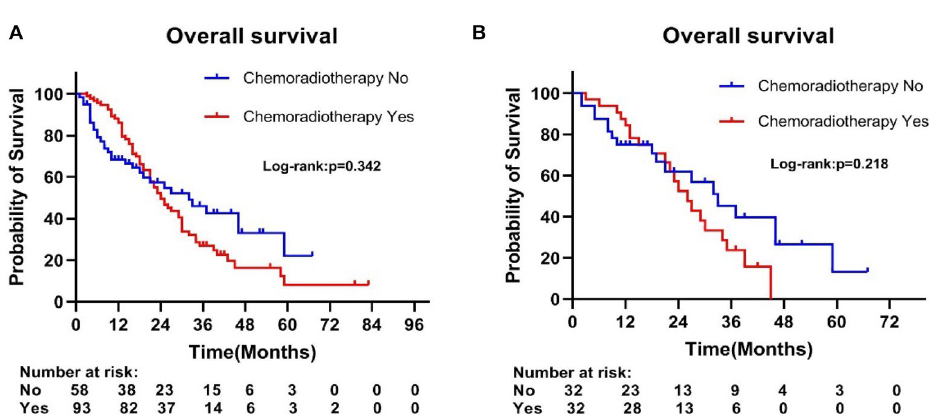
Figure 4. Kaplan–Meier curves of overall survival ( A ) before PSM and ( B ) after PSM according to whether patients underwent chemoradiotherapy in the surgery